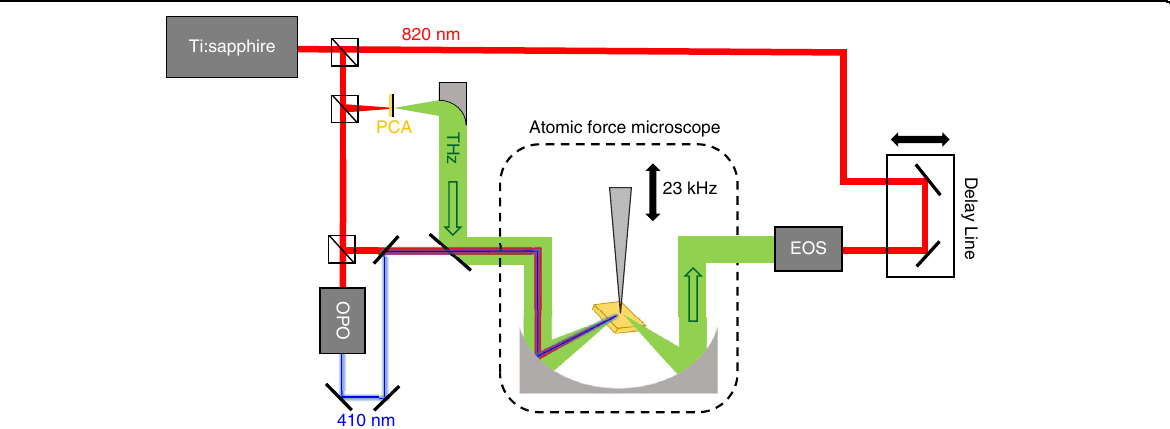
Fig. 1 Schematic of laser path and s-SNOM experiment. NIR, blue light, and THz beams are generated separately, with the THz pulses generated using a conventional photoconductive antenna (PCA). All three beams then overlap and are coupled into the AFM. Scattered or emitted THz pulses are coherently detected on the other side via free-space electro-optic sampling